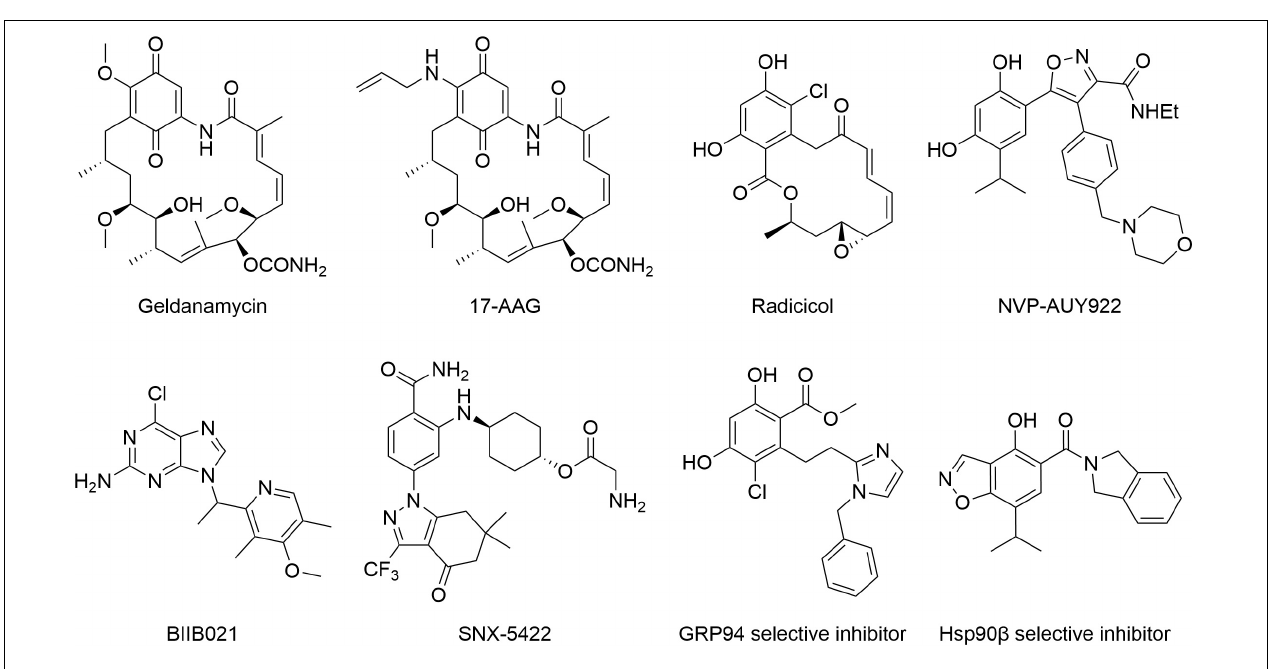
FIGURE 2 | Hsp90 chaperone cycle. Open conformation state is likely to be the most efficient at binding client proteins. Addition of ATP altering the relationship between the NTD and MD, resulting in a transient NTD/MD conformation. Co-chaperones assist in loading client proteins onto Hsp90. Aha1 increases Hsp90 ATPase activity, contributing to the closing of the NTD. Client proteins would remain bound due to the hydrophobic surfaces still present on the MD and CTD. Client proteins are folded during the process of NTD closure. Finally, nucleotide hydrolysis results in the very compact ADP state and the release of client proteins. Open conformation of the Hsp90 NTD is restored for the next chaperone cycle.